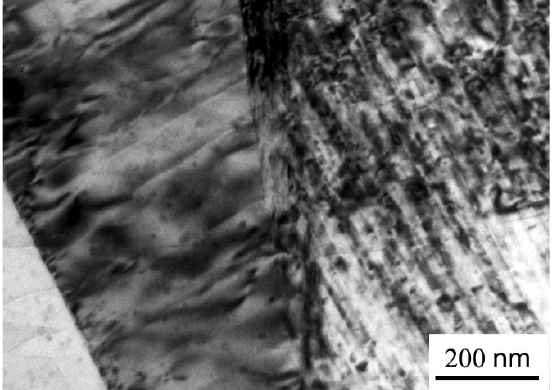
Figure 10. TEM of weld seam with 3 mg/cm 2 activated flux and magnetic field.